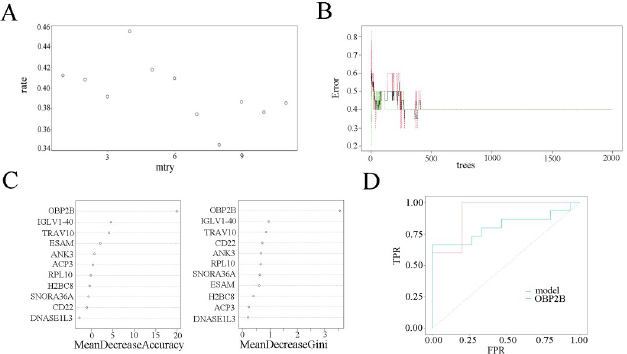
Fig 4. Construction of random forest model. (A) The scatter plot of the false-positive rate. The vertical axis represents the false positive rate, and the horizontal axis represents mtry index (from 1 to 11). (B) Relationship between the related errors and the number of decision trees. The vertical axis represents the related errors, and the horizontal axis represents the number of decision trees. (C) The scatter plot of the random forest variable based on the index of mean decrease accuracy (the left panel) and mean decrease Gini (the right panel), respectively. (D) Evaluation of the prediction efficiency of the random forest model via ROC curve. Red line represents the random forest model, and green line represents OBP2B gene.